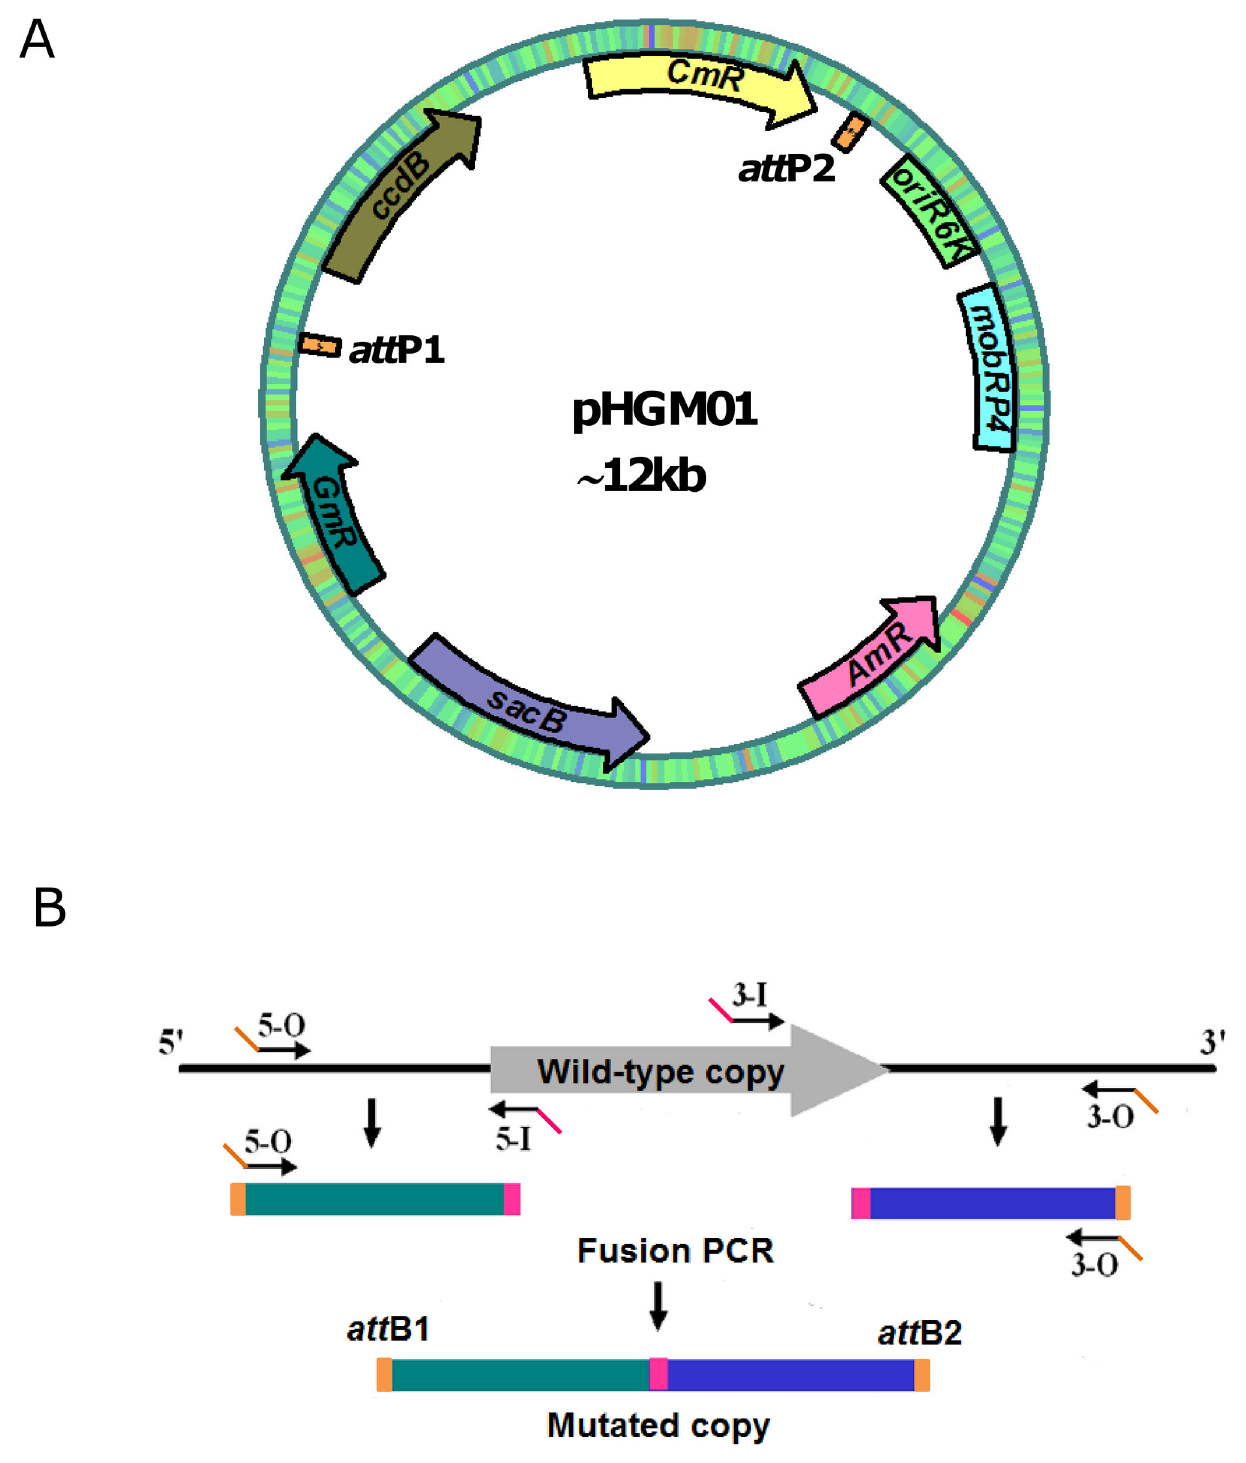
Figure 2. The att -based mutagenesis developed in this study. A . Mutational construct delivery vector pHGM01. The vector was created by introducing into the Sac I site of pDS3.0 a fragment containing att P1, ccdB , Cm R , and att P2 amplified from pMK2010. B . Generation of a fusion PCR product for BP recombination. Outside primers 5-O and 3-O contain att B1 and att B2 sequences, respectively. Inside primers 5-I and 3-I contain linking sequences respectively, which are complementary to each other.